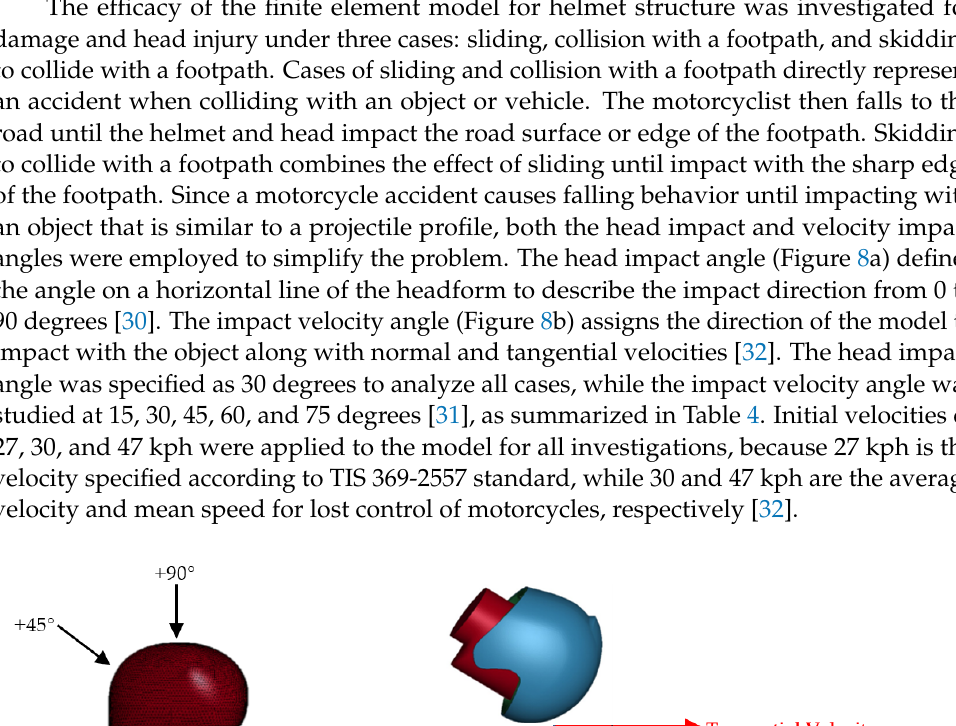
Figure 7. Energy absorption with different positions under the impact test.